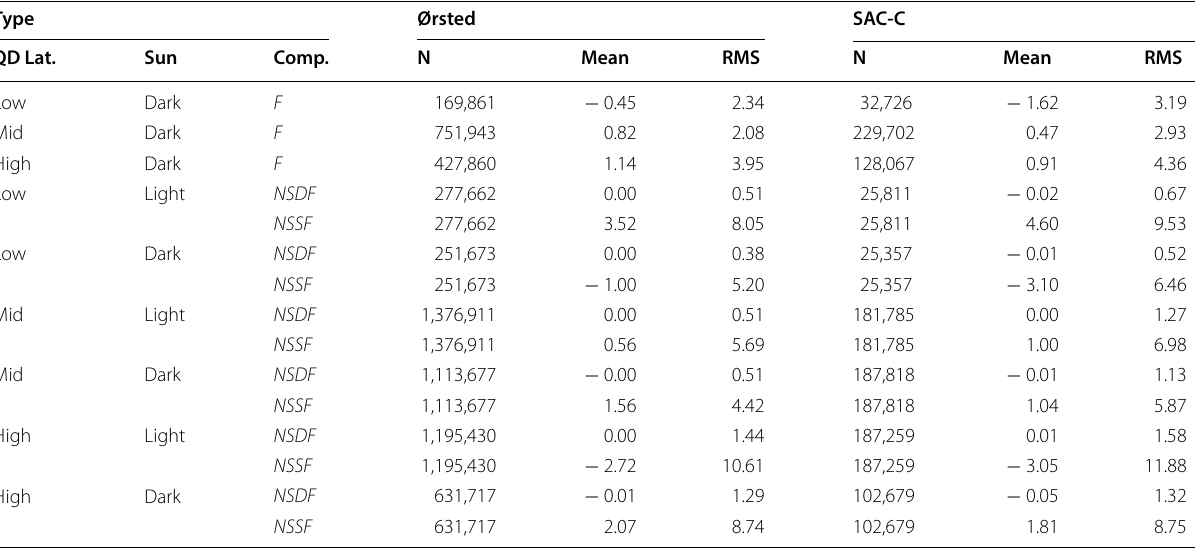
Mean and RMS are in units of “nT”